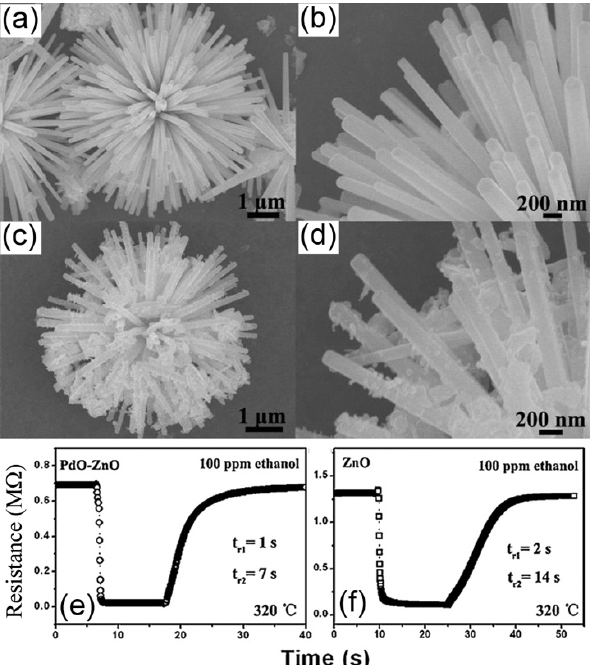
Figure 4. SEM images of pure flower-like ZnO ( a , b ) and the PdO nanoparticle-decorated ZnO (n-p junctions) ( c , d ), the dynamic sensing performance of the sensor based on the PdO nanoparticle- decorated ZnO ( e ) or pure ZnO ( f ) to 100 ppm ethanol at 320 °C. Copied with permission [42]. Copyright 2013, Elsevier.